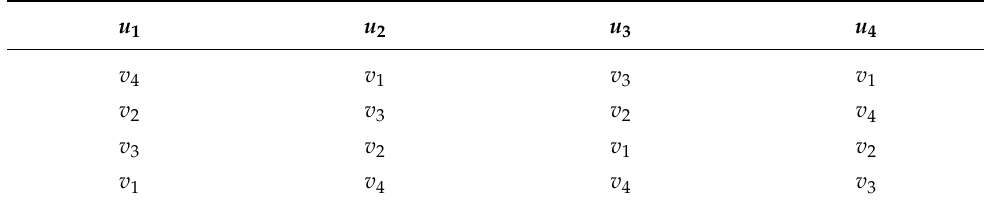
Table 4. User preferences over VSPs.